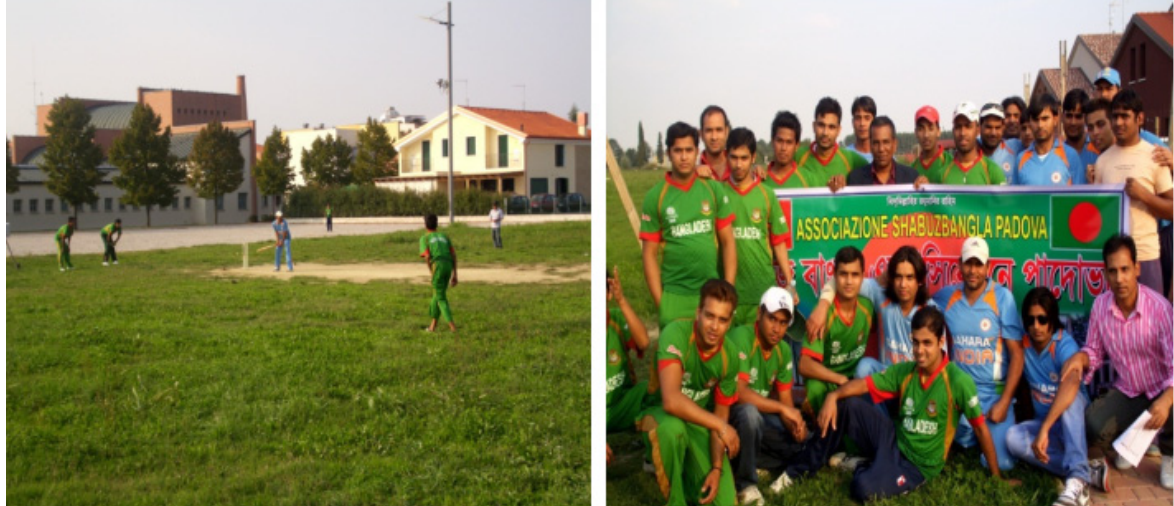
Figure 3. A cricket match between second generation Bangladeshis and Indians in Padova, Italy. Source: Fieldwork (2013).